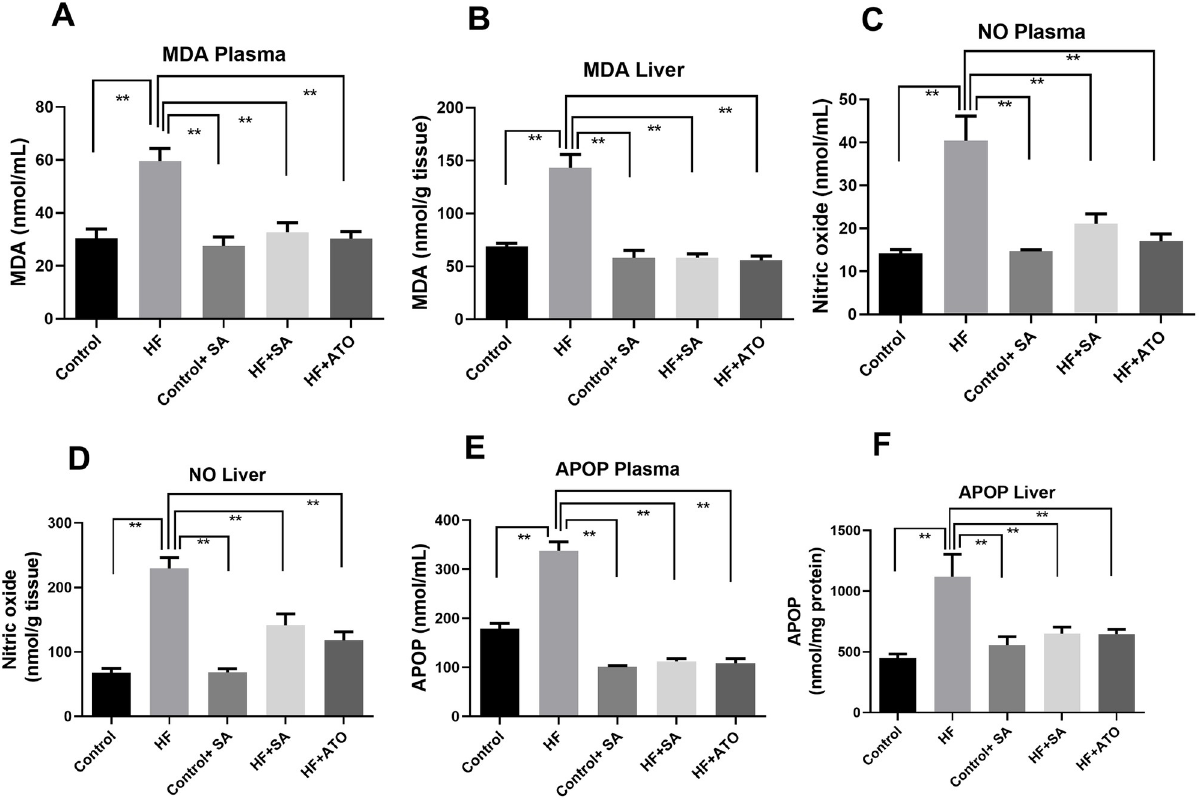
Fig 4. Effect of Senna alexandrina leaf powder supplementation on oxidative stress markers. A. MDA in plasma. B. MDA in liver. C. NO in plasma. D. NO in liver. E. APOP in plasma. F. APOP in liver. Mean ± standard error of mean (SEM) was used to express all values, where n = 8. Statistical analysis was done by one-way ANOVA and comparisons among the groups were done following Tukey’s multiple comparisons test. �� represents p � 0.001.